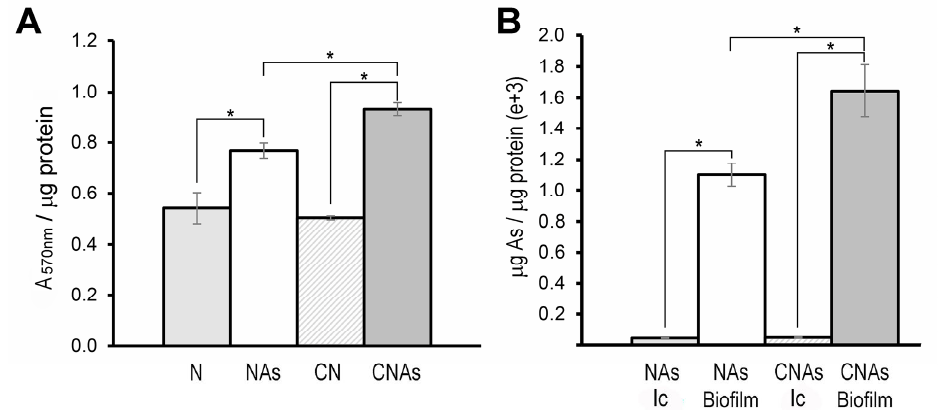
Figure 3. Biofilm production in P. pseudoalcaligenes CECT 5344 and arsenic accumulation in the biofilm. ( A ) Biofilm formation (measured with crystal violet as A 570nm ) normalized by protein amount ( µ g) in cells grown with 2 mM ammonium as a nitrogen source in the absence (N) or the presence of 0.25 mM arsenite (Nas), or with 2 mM cyanide as nitrogen source, without (CN) or with 0.25 mM arsenite (CNAs). ( B ) Intracellular (Ic) and biofilm As accumulation in cells grown with 0.25 mM arsenite using ammonium (Nas) or cyanide (CNAs) as the sole nitrogen source. Asterisks indicate that the differences are significant ( p < 0.05) according to a t-test.